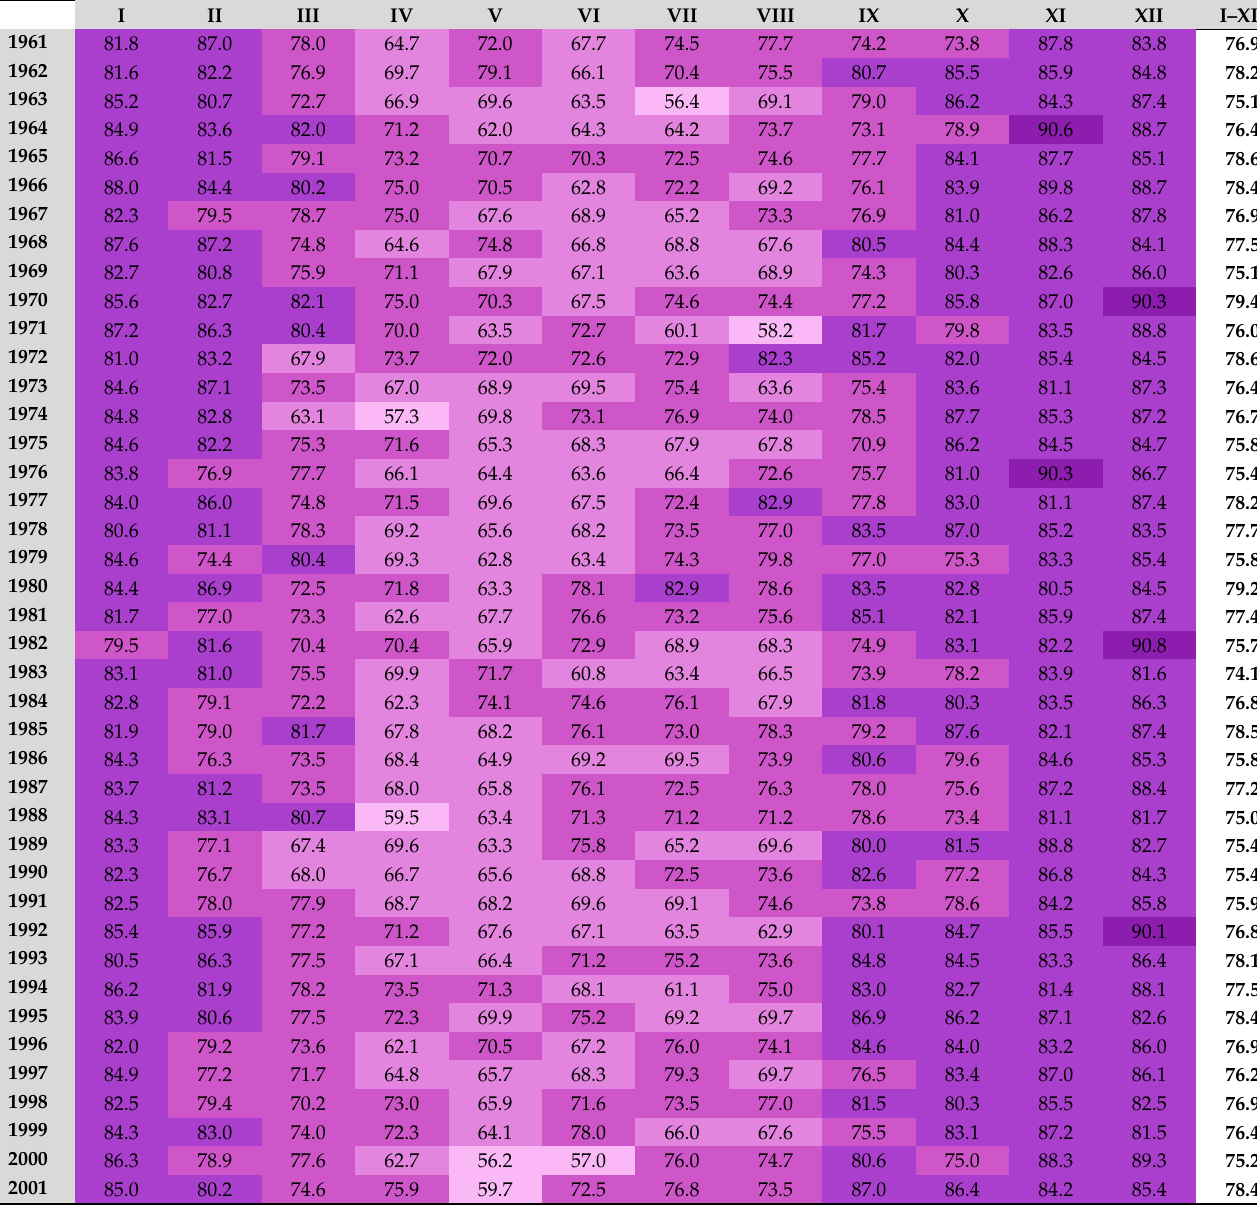
Table 2. Monthly average relative humidity from 1961 to 2020 in